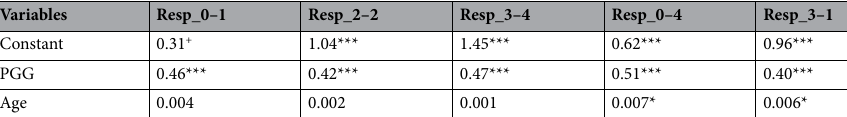
Table 8. OLS estimates for specifications (9). + p < 0.15 (marginally significant), *p < 0.05, **p < 0.01, ***p <